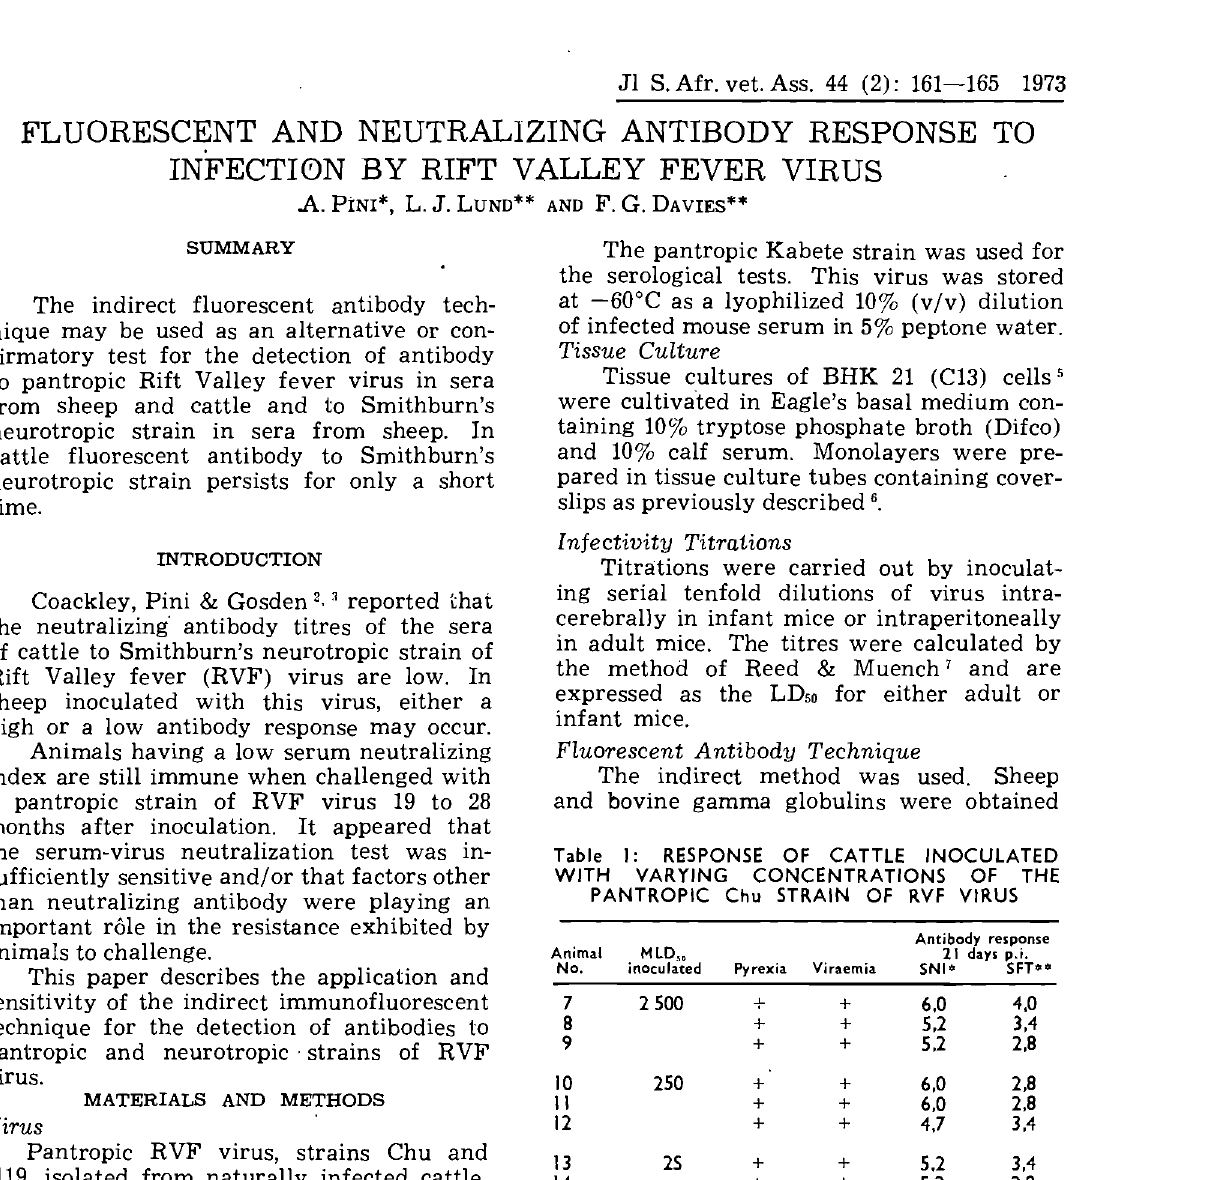
RESPONSE OF CATTLE INOCULATED WITH VARYING CONCENTRATIONS OF THE PANTROPIC Chu STRAIN OF RVF VIRUS Animal